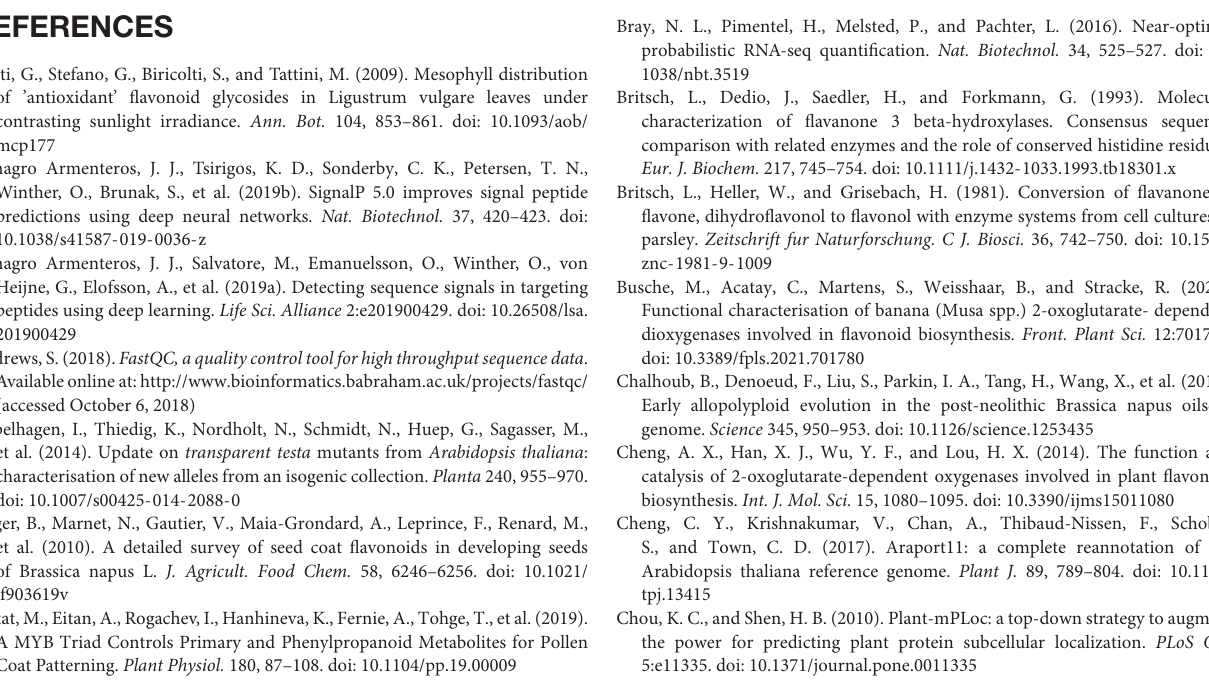
Supplementary File 1 | List of plant 2-ODDs amino acid sequences used in phylogenetic analysis. Supplementary File 2 | 3D secondary structure models used in this work. Supplementary File 3 | Corrected structural annotation of BnaFLS genes. Supplementary File 4 | CDS of BnaFLSs from this